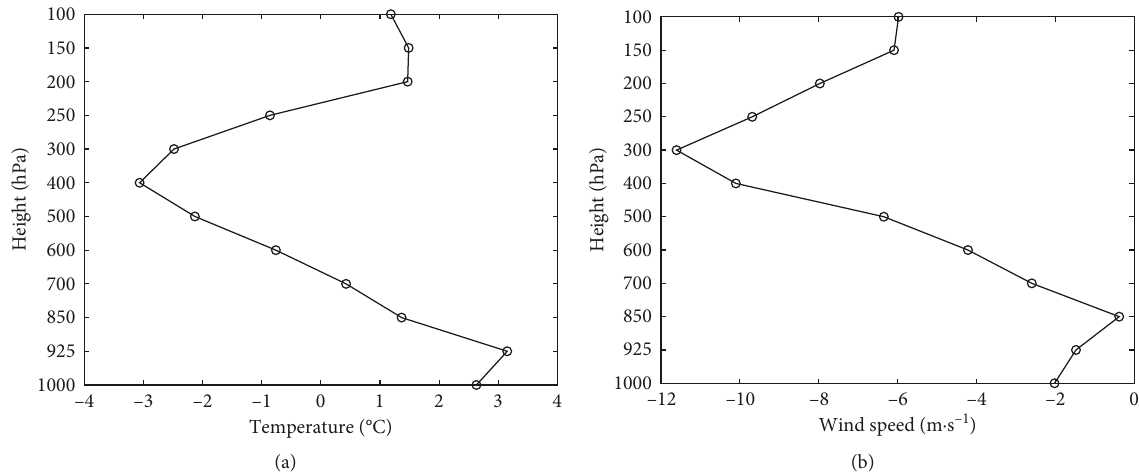
Figure 6: Vertical profiles of temperature anomaly (a) and wind speed anomaly (b) of Jiangsu area from 1 to 9 December